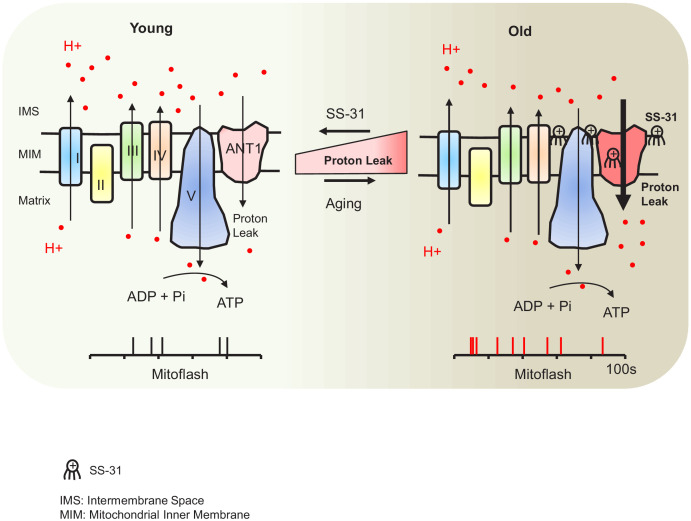
Schematic of the mechanism of SS-31 protection of proton leak and rejuvenation of mitochondrial function.Due to increased mitochondrial proton leak, the mitochondria work harder to maintain ATP production, and thus the work load is increased in the aged heart.